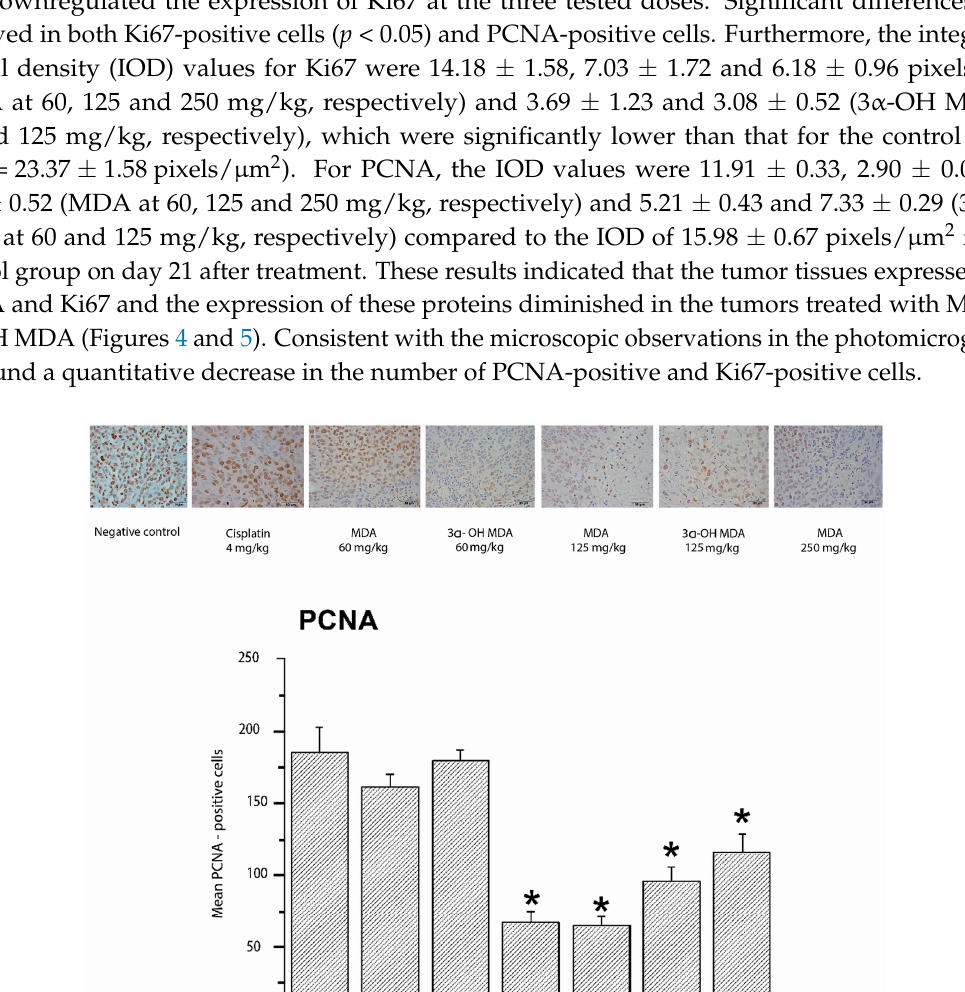
The inhibition of cell proliferation induced by MDA and 3 α -OH MDA was evaluated by the expression of two markers of cell proliferation, proliferating cell nuclear antigen (PCNA) and Ki67. MDA at doses of 125 and 250 mg/kg decreased the average number of cells positive for PCNA and downregulated the expression of Ki67 at the three tested doses. Significant differences were observed in both Ki67-positive cells ( p < 0.05) and PCNA-positive cells. Furthermore, the integrative optical density (IOD) values for Ki67 were 14.18 ± 1.58, 7.03 ± 1.72 and 6.18 ± 0.96 pixels/µm 2 (MDA at 60, 125